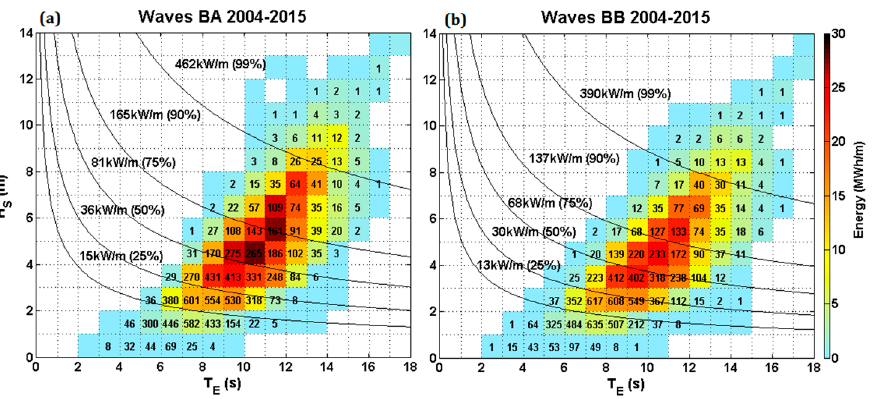
Figure 28. Bi-variate scatter plots for ( a ) BA and ( b ) BB for 2004–2015 showing numbers of occurrence (in hours) and contribution to total energy of H s and T E , with wave power isolines included.